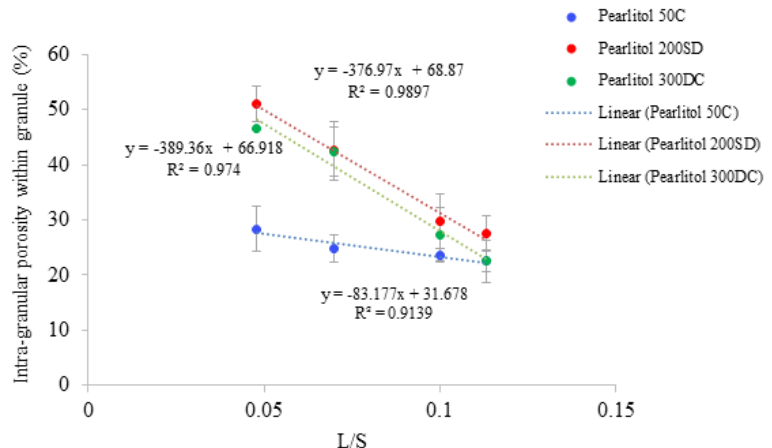
Figure 14. Porosity of granules for different grades of mannitol powder at varying L/S (screw speed, 450 rpm).